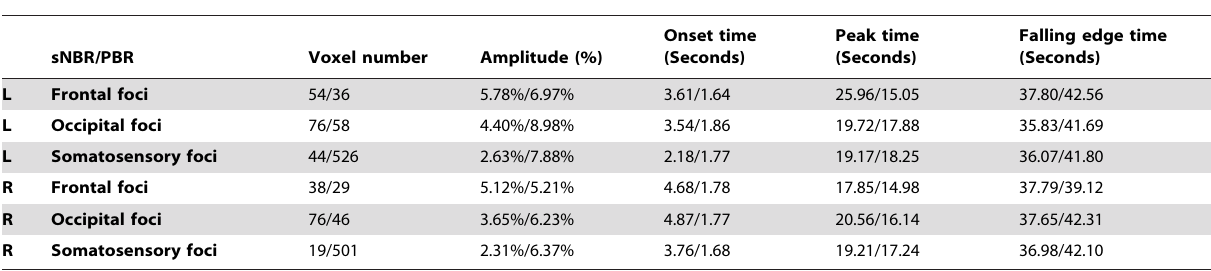
Table 1. Areas, amplitudes and dynamic features for sNBR and PBR.